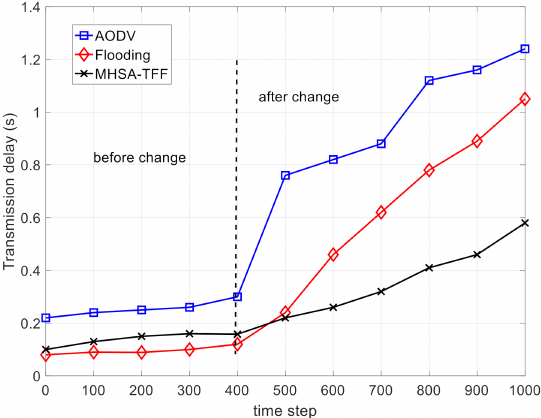
Figure 4. The comparison on the transmission delay.